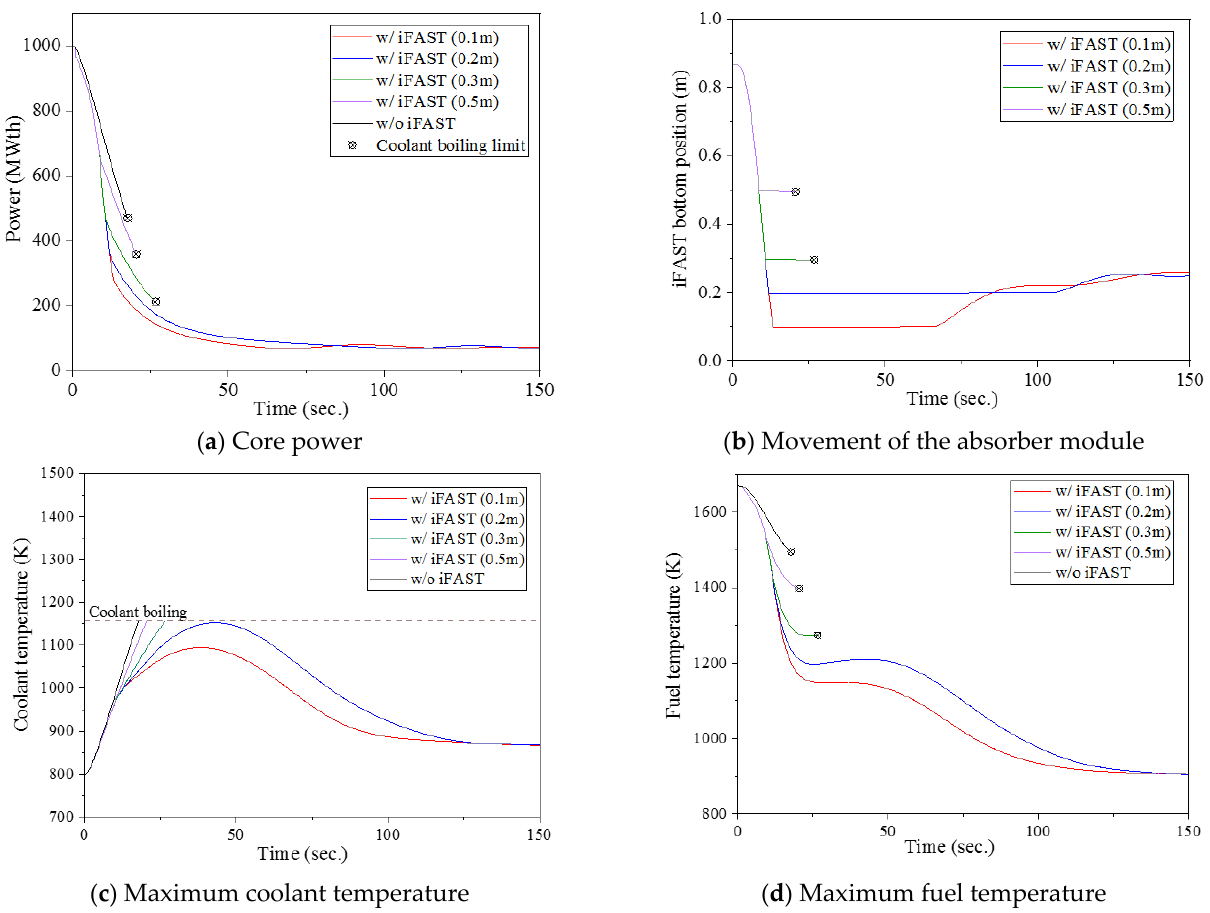
Figure 6. Unprotected loss of flow in ABR reactor and 1$ maximum iFAST worth.